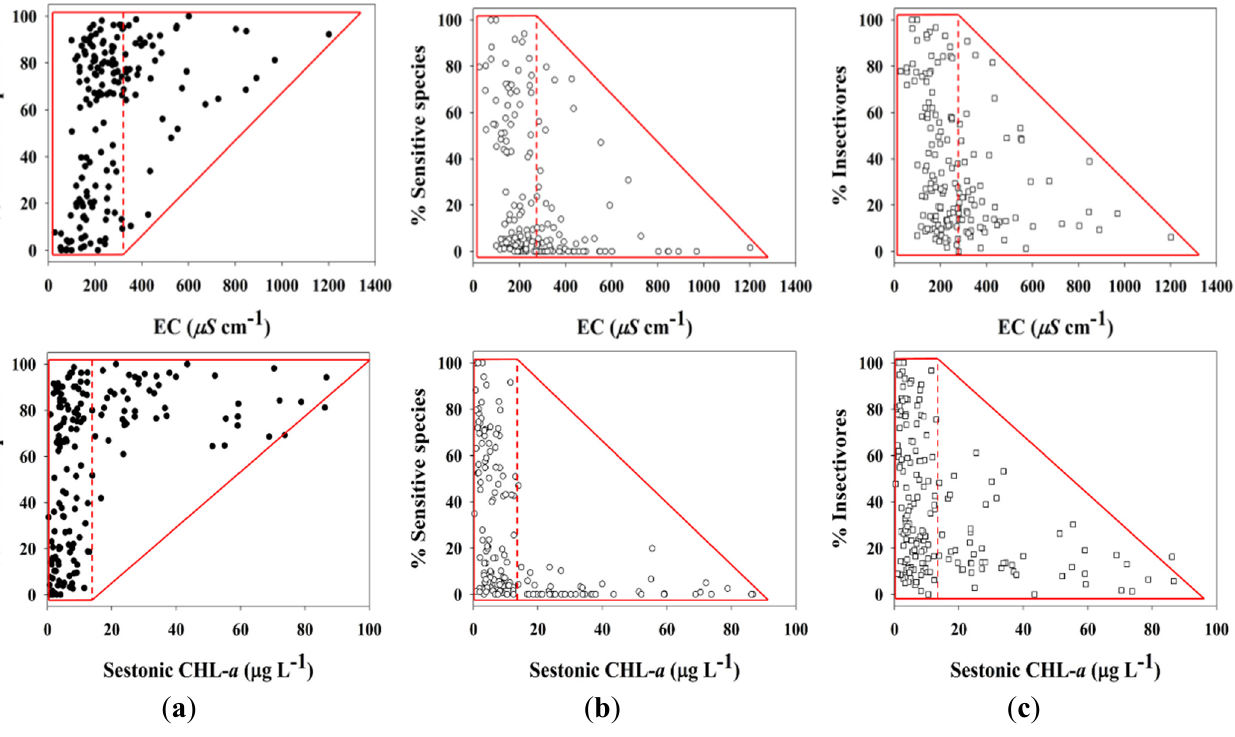
Figure 5. The relation of fish indicators (tolerance and trophic species) to water quality parameters (total phosphorus (TP), biochemical oxygen demand (BOD), electrical conductivity (EC), sestonic chlorophyll-a (Chl- a )): ( a ) % Tolerant Sp.; ( b ) % Sensitive Sp.; and ( c ) % Insectivores